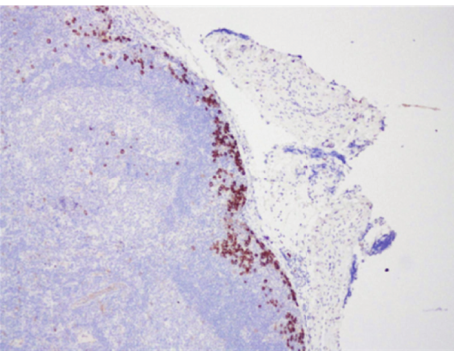
Figure 4: CD30 immunohistochemistry of sentinel node demon- strating metastatic